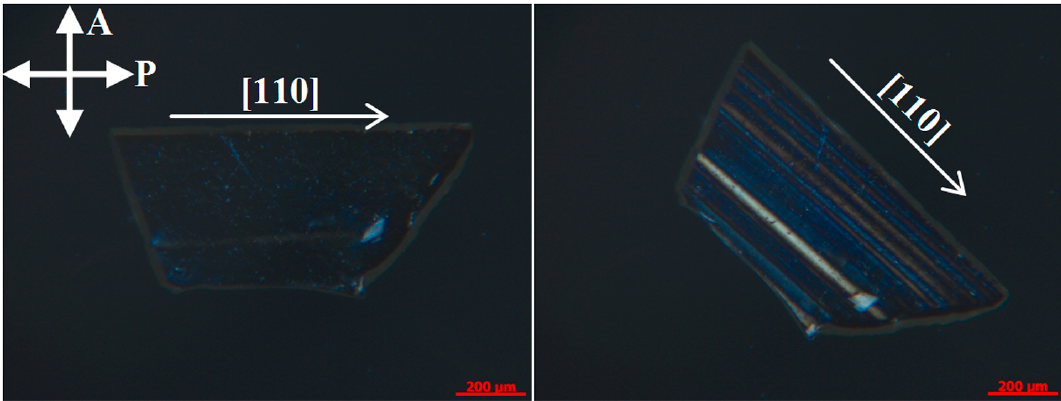
Figure 4. Micrographs of [111]-oriented plates of PLN-0.07PT crystal under a crossed polarized light microscope (shown by arrows) at room temperature.